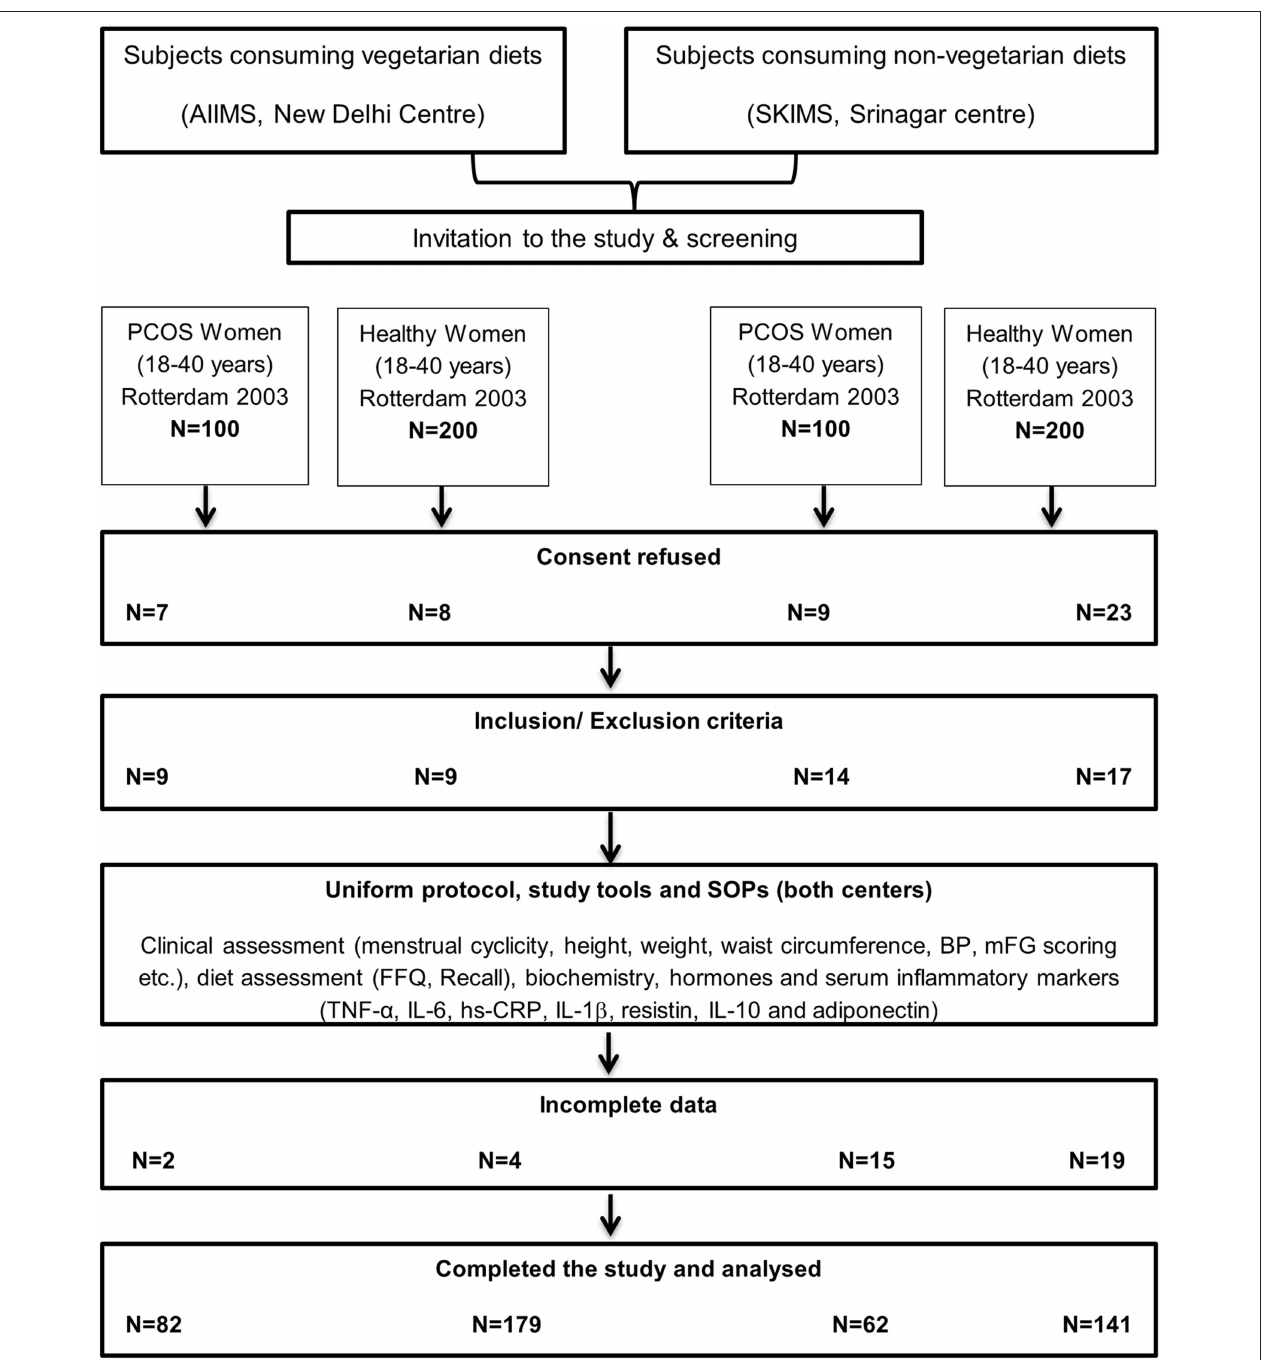
FIGURE 1 | Showing PERT chart describing the flow of subjects throughout this study.